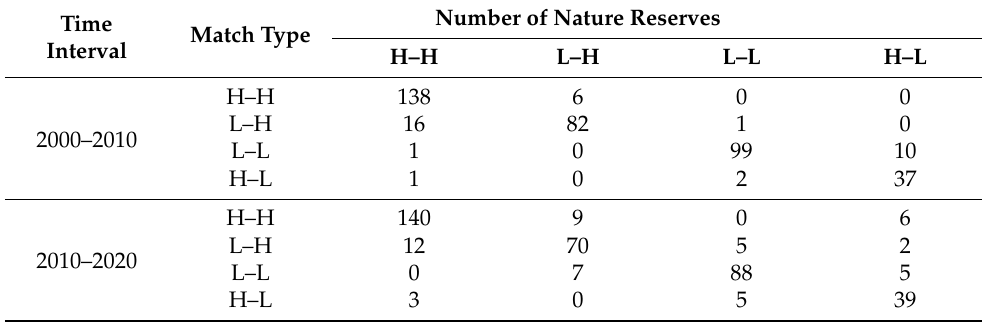
Table 3. Transfer of matching supply and demand for ecosystem services from 2000 to